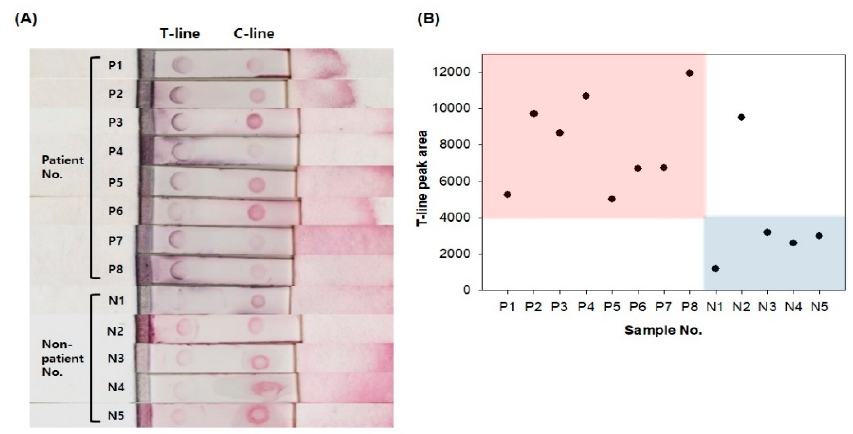
Figure 6. ( A ) Response of pepsin strip sensor in human saliva samples. ( B ) Colorimetric signal intensity graph in human saliva samples.